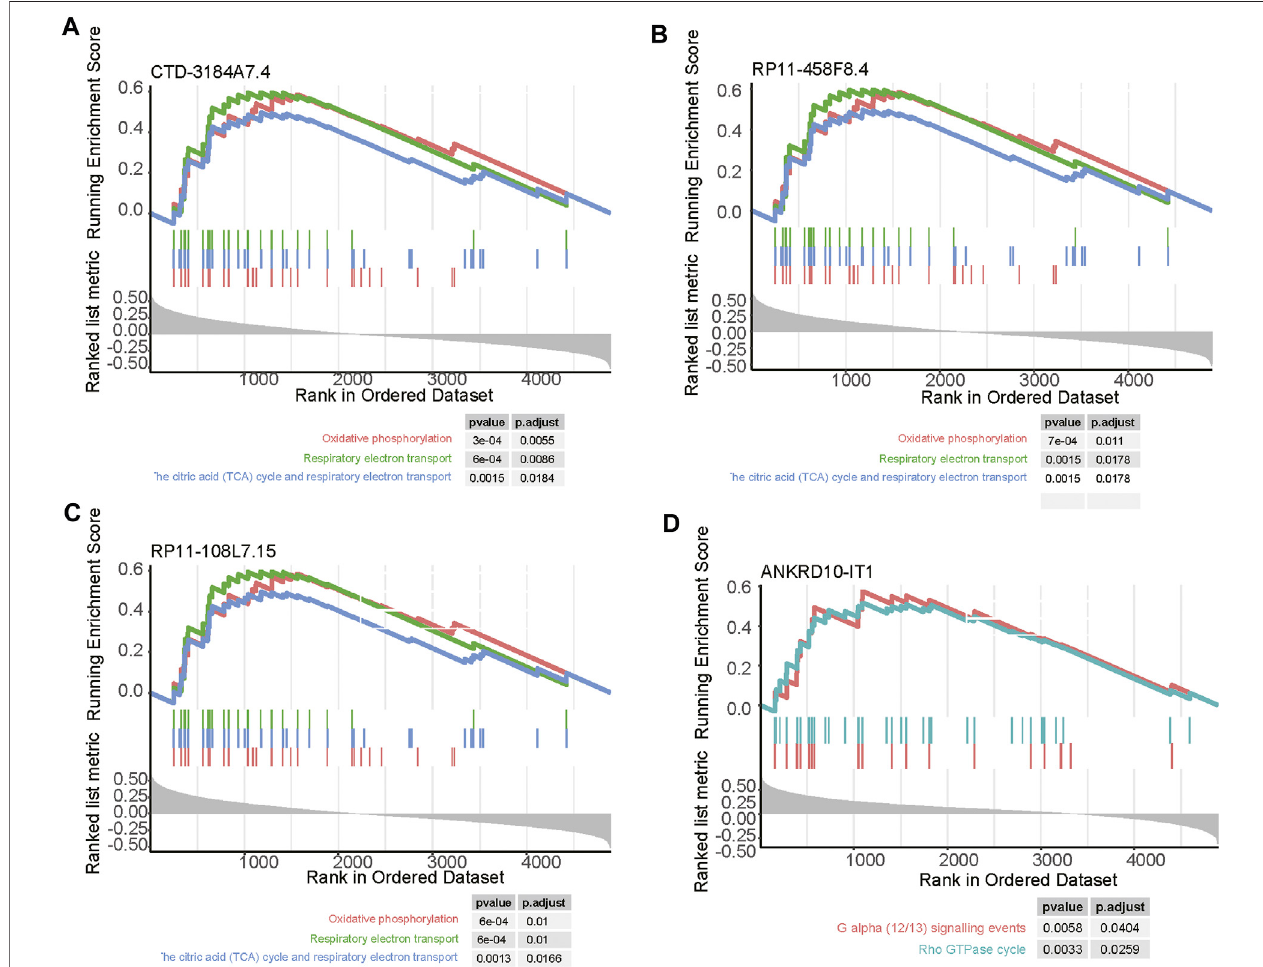
FIGURE 7 | The pathways related to the four m6A-related lncRNAs. The pathways enriched by the positively correlated genes with (A) CTD-3184A7.4, (B) RP11- 458F8.4, (C) ANKRD10-IT1, and (D) RP11-108L7.15. The vertical lines under the lines represent the genes involved in the pathways. The left and right vertical lines indicated the positively and negatively correlated genes with the